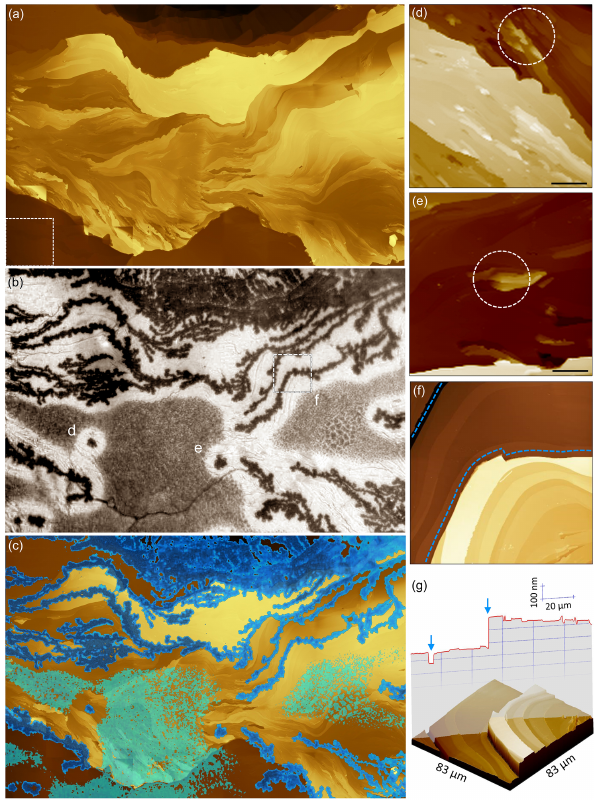
Figure 4. Wide-field-of-view colocation of AFM data and op- tical video of ice growth at − 29 . 5 ± 0 . 5 ◦ C and AH in = 0 . 80 ± 0 . 08gm − 3 . (a) A mosaic composed of 54 individual AFM im- ages stitched together to form a topographical map spanning 750µm × 570µm. The box with the dashed outline on the lower left represents the 100µm × 100µm size of each individual AFM image. Brighter color represents higher topography. (b) An opti- cal video frame captured over the same area as in (a) showing ice growth. Three locations of interest are marked on the optical im- age (d, e, f) , and AFM images corresponding to their locations are shown in the panels on the right with the same labels. (c) The optical image in (b) is thresholded and false-colored and then overlaid on the AFM data shown in (a) . The resulting overlay demonstrates the preference of ice formation along prominent step edges. (d, e) Two example regions where ice nucleated on the surface and grew as iso- lated crystals without propagating across steps. Circles with dashed outlines enclose the locations where ice nucleation occurred. Scale bars are 5µm. (f) Planar and (g) 3D view of the region marked f in (b) . Dashed lines in (f) represent the path followed by ice, and the arrows in the height profile in (g) mark locations of ice forma- tion. Video data accompanying panel (b) can be found in Friddle and Thürmer